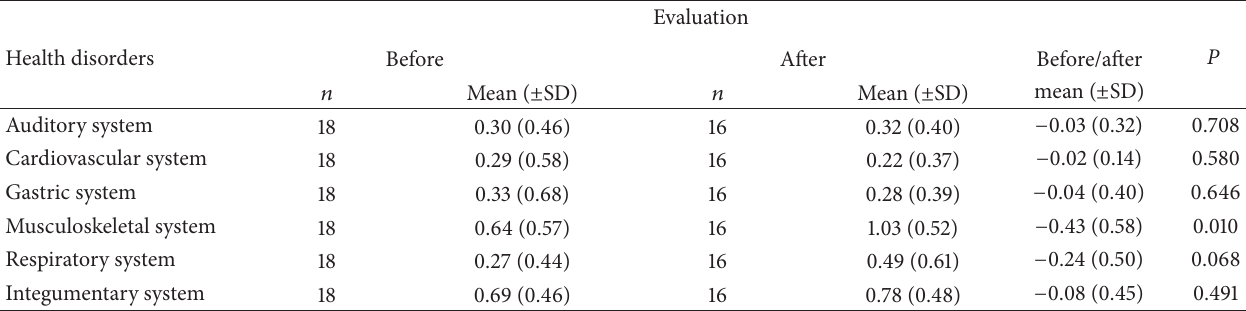
Table 4: Percentage change in average of identification of health disorders self-reported for women apprentice welders before and after nursing socioenvironmental intervention ( 𝑛 = 18 ).